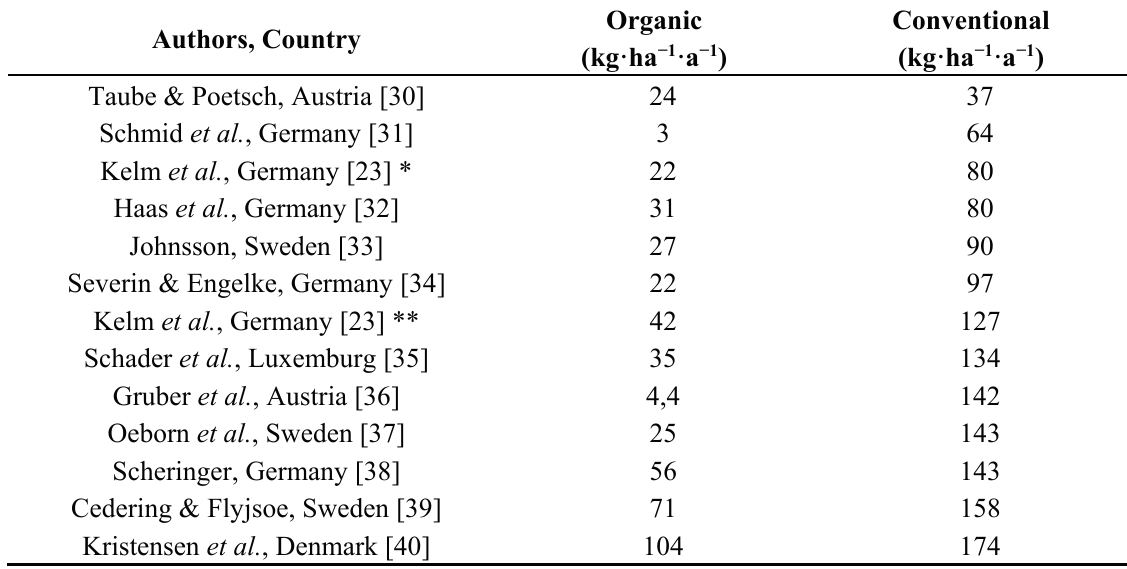
Table 1. Studies reporting N surpluses of organic farms in comparison to conventional farms (*: arable farms, **: dairy